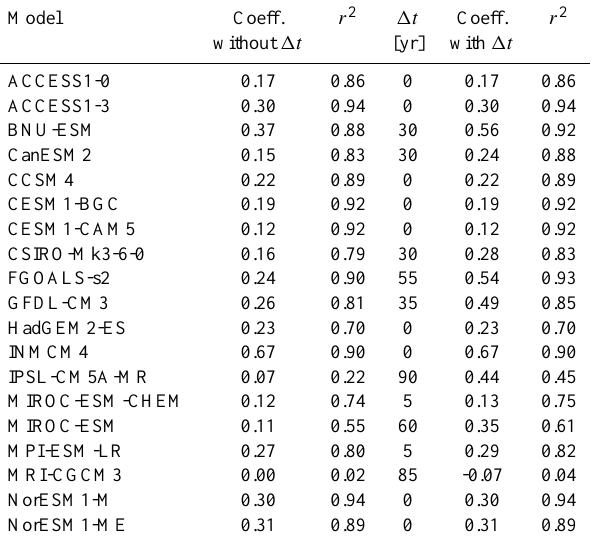
Table 2. Amundsen Sea sector: scaling coefficients and time delay 1t between increases in global mean temperature and subsurface ocean temperature anomalies.